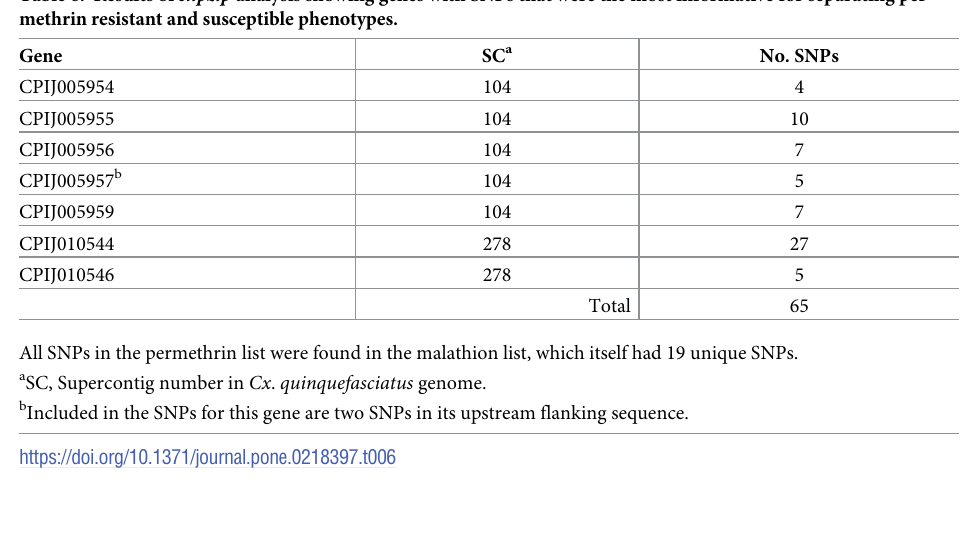
Table 6. Results of snpzip analysis showing genes with SNPs that were the most informative for separating per- methrin resistant and susceptible phenotypes. Gene SC a No. SNPs CPIJ005954 104 4 104 10 104